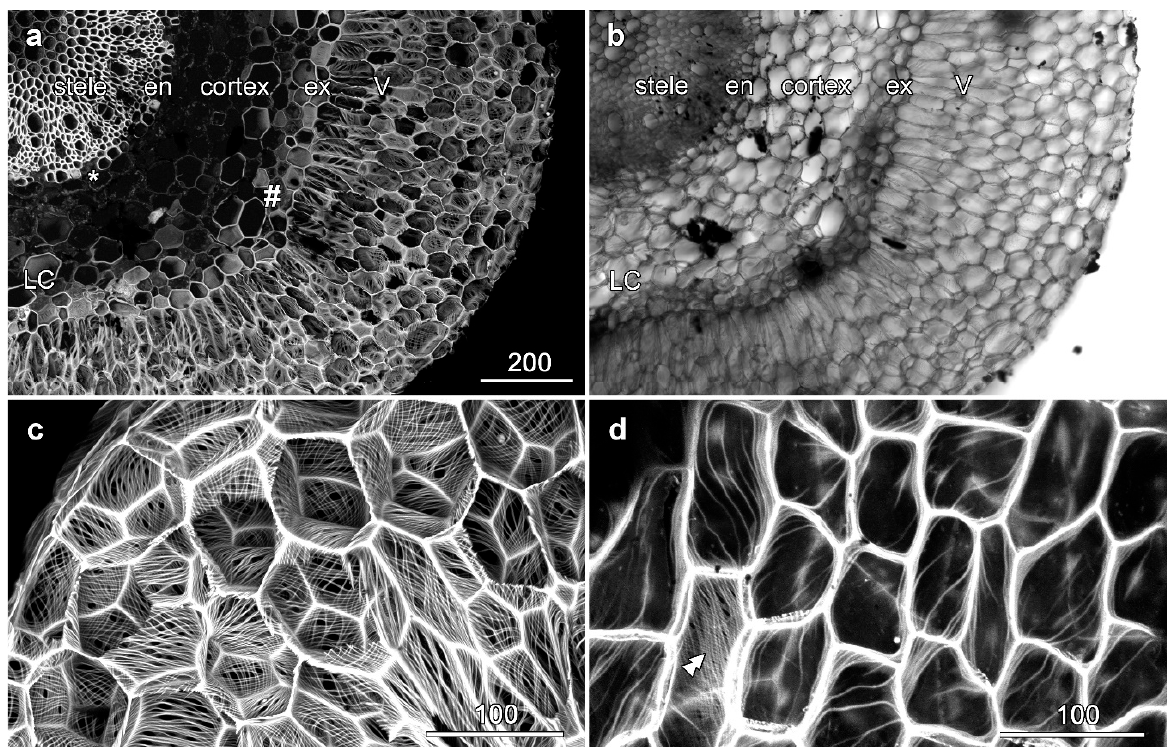
Figure 2. Velamen organization in Miltoniopsis sp. roots. Images ( a , c , d ) are maximum projections of confocal optical series showing basic fuchsin-stained lignin. ( a , b ) Cross section showing lignified cell walls and a concurrent transmitted light image. The wide velamen (V) surrounds the lignified exodermis (ex) and the cortex which contains lignified cortical cells (LC), while a lignified endodermis (en) surrounds the central stele. Passage cells through the endodermis (*) and velamen (#) walls are marked. ( c ) Higher resolution imaging of the criss-crossed cell wall thickenings in the velamen. ( d ) A longitudinal section shows only scattered wall thickenings in the outer wall of the outer velamen (asterisks). A region where the inner face of these cells was imaged, and which shows the criss-crossed pattern, is indicated by a double arrowhead. See also Supplementary Movies 1 and 2. Bar in ( a ) = 200 µm for ( a , b ); bars in ( c , d ) = 100 µm.